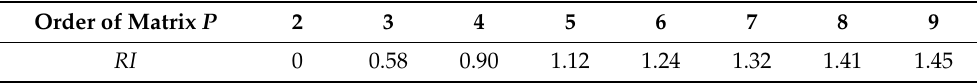
Table 4. The value of RI .